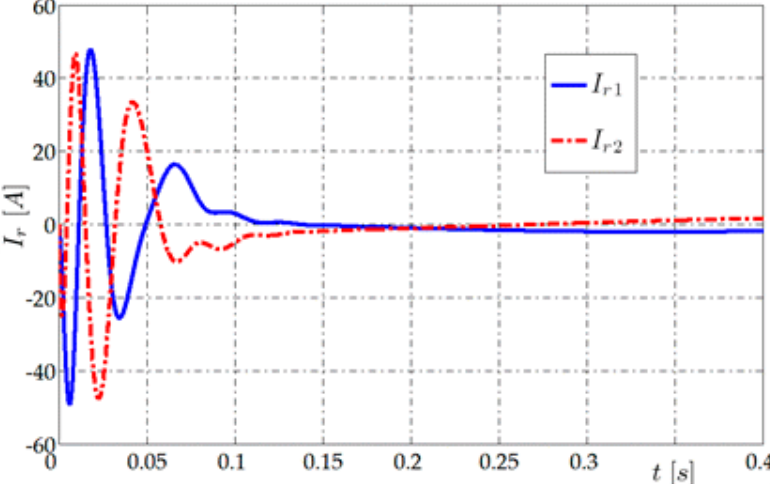
Figure 7. The phase currents in the rotor windings during the start ‐ up motor for load torque 1 Nm.